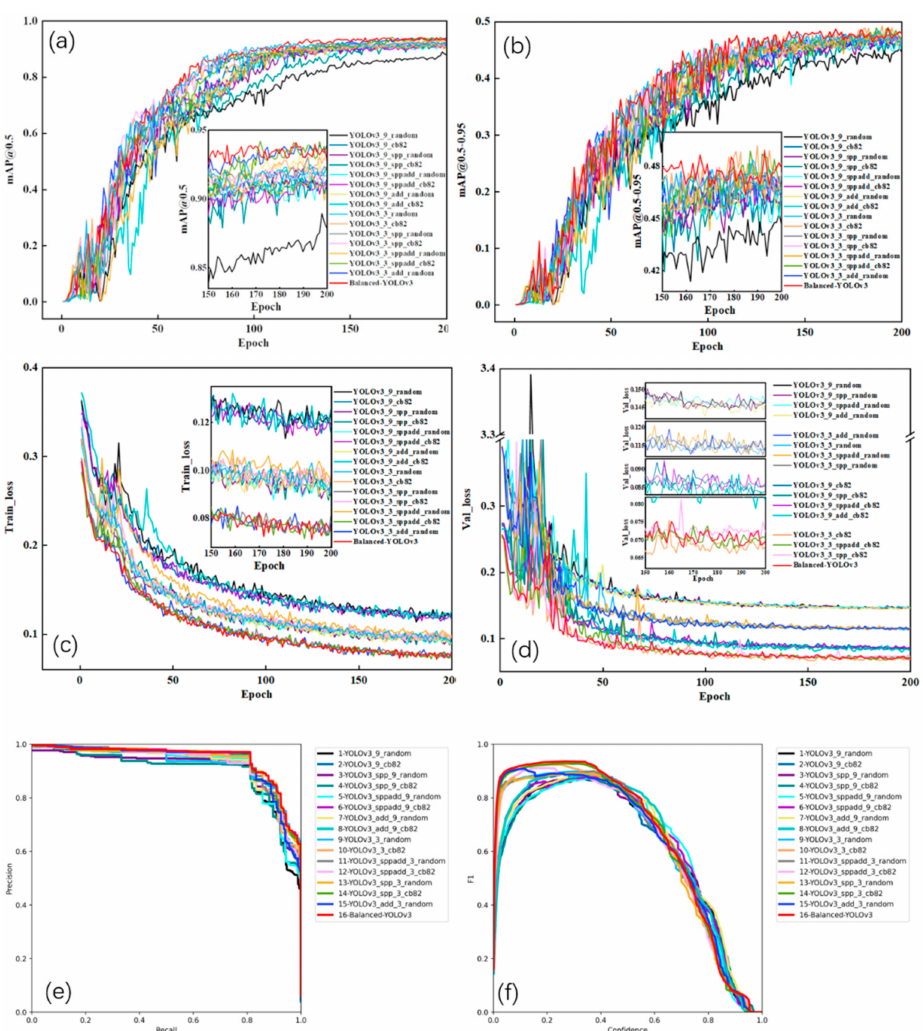
Figure 11. Sixteen sets of algorithm experiment process curve diagrams. ( a ) mAP@0.5-Epoch change trend curve. ( b ) mAP@.5:.95-Epoch change trend curve. ( c ) Ttain_loss-Epoch change trend curve. ( d ) Val_loss-Epoch change trend curve. ( e ) Precision-Recall curve. ( f ) F1